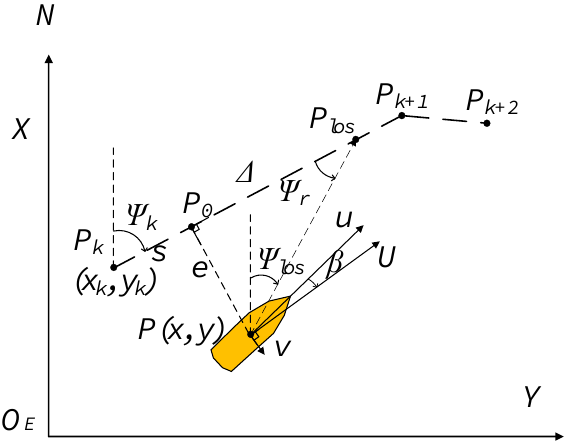
Figure 4. The LOS method of path tracking for a MASS. It is set that P k and P k +1 are the adjacent track points that the MASS has arrived at and not arrived at. The angle between P k and P k +1 and the longitudinal axis of the inertial coordinate system is Ψ k , and the vertical intersection with P 0 is made from the MASS position P to two points. The distance, e, between the two points represents the transverse error. The position of the straight line P 0 P k +1 , distance P 0 , distance ∆ is P los , where ∆ represents the forward distance, which is generally 2–4 times that of the length of the